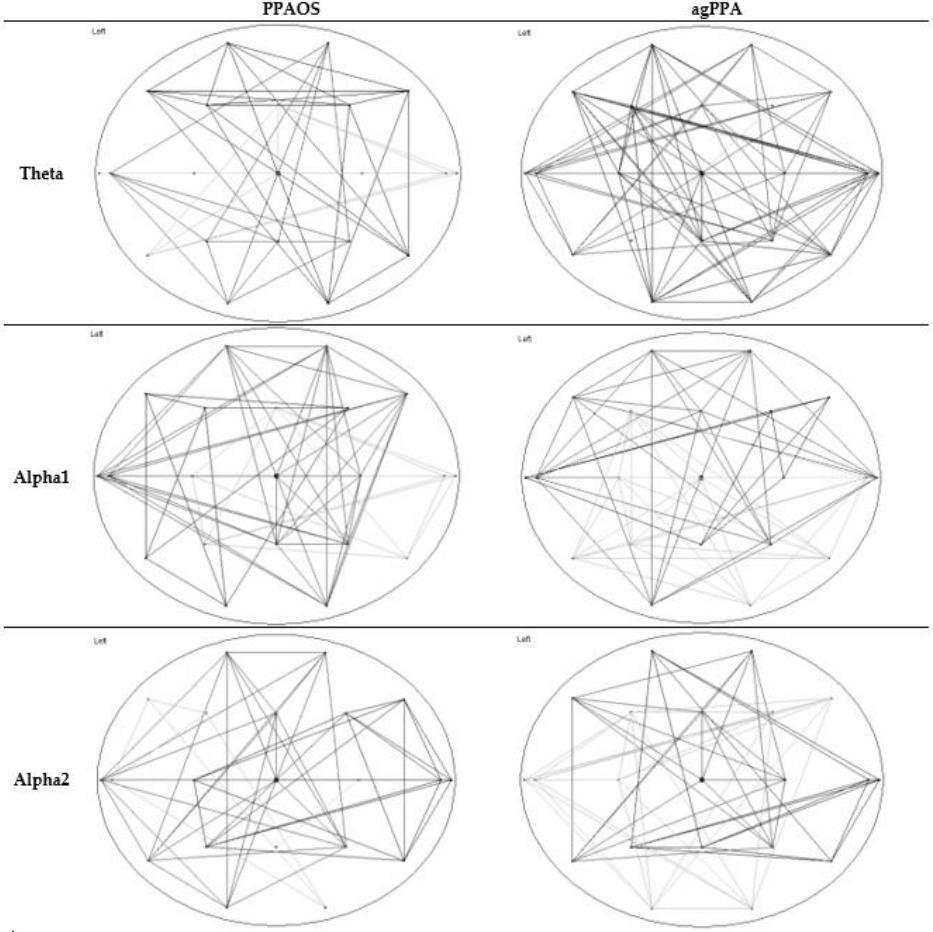
Figure 3. Average network maps separating the agPPA patients and PPAOS, for the theta, alpha1, and alpha2 frequency bands. The maps demonstrate the presence of correlations between pairs of channels, with threshold of 0.1 (PLI value) or correlations above that threshold.